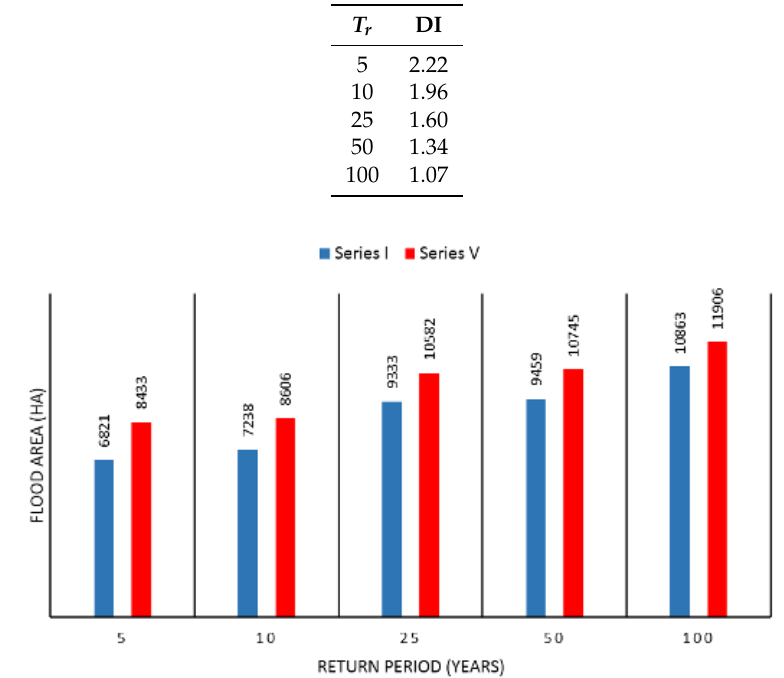
Table 5. Flood Depth Index values obtained as the difference between flood levels calculated for Series I and Series V of land use, for each return period.